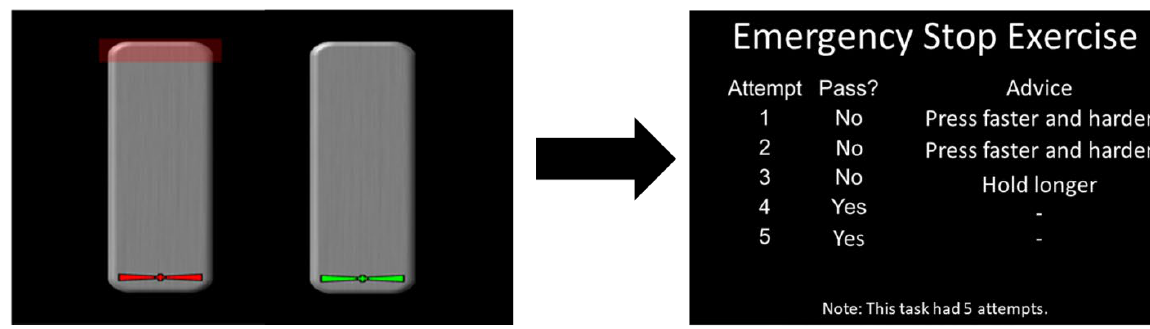
Figure 9. Current Pedals Emergency Stop© interactive exercise, which rotates between the task screen with the pedals and the results screen.